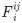
Schema of contact model.(a) The interaction force in the adhesive contact model. (b) The relationship between the contact force Fiij and the distance r0.